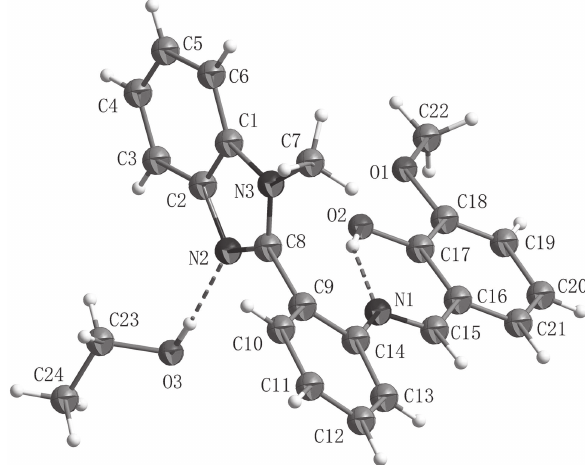
Table 2: Fractional atomic coordinates and isotropic or